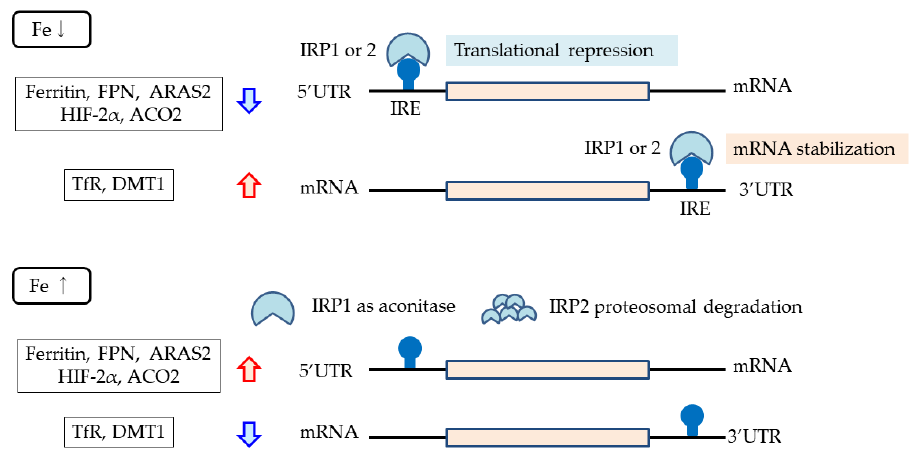
Figure 4. IRE–IRP system. When an IRP binds to an IRE in the 5′ untranslated region (5′ UTR), translation is inhibited, whereas when it binds to an IRE in the 3′ UTR, mRNA stability is increased and translation is enhanced. IRPs are activated and bind to IREs only under iron deficiency. Proteins with IREs in the 5′ UTR include ferritin, ferroportin, ARAS2, and ACO2. Proteins with IREs in the 3′ UTR include transferrin receptor and DMT1. ARAS2, erythroid-specific delta-aminolevulinate synthase; ACO2, mitochondrial aconitase 2; IRE, iron-responsive element; IRP, iron regulatory pro- tein.